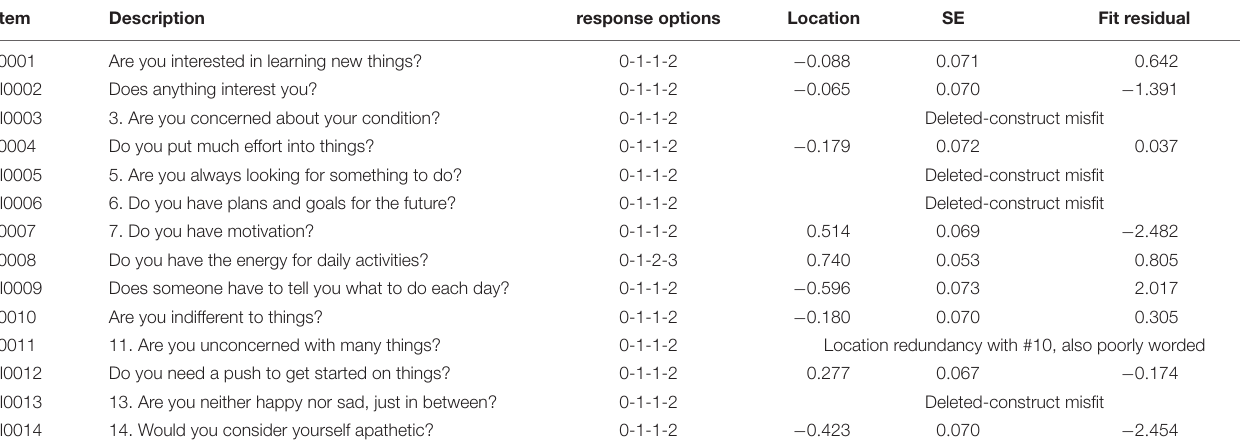
TABLE 2 | Starkstein’s Apathy Scale items